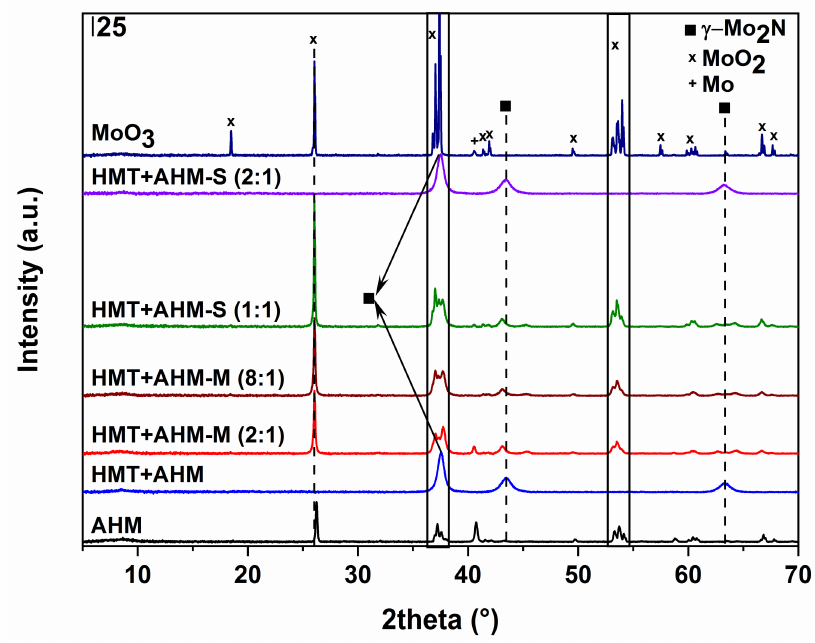
Figure 11. X-ray diffraction patterns of the molybdenum nitrides prepared at 700 ◦